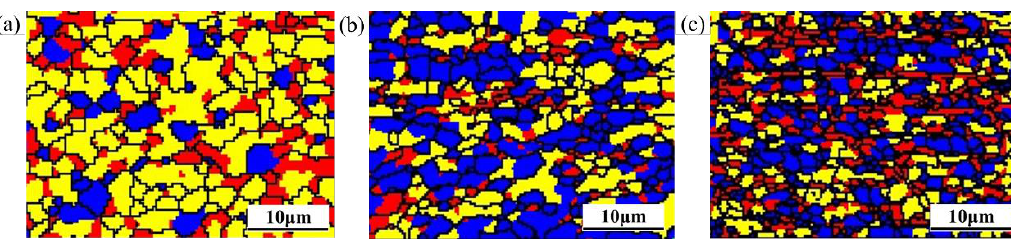
Figure 6. EBSD recrystallization maps of the pure Al ( a ) and Al/CNTs nanocomposites with 0.5 ( b ) and 1.0 ( c ) vol.% CNTs after 12 ARB cycles. The blue, yellow and red grains are denoted as recrystallized, substructured and deformed grains, respectively. RD-ND section with RD parallel to scale bar.